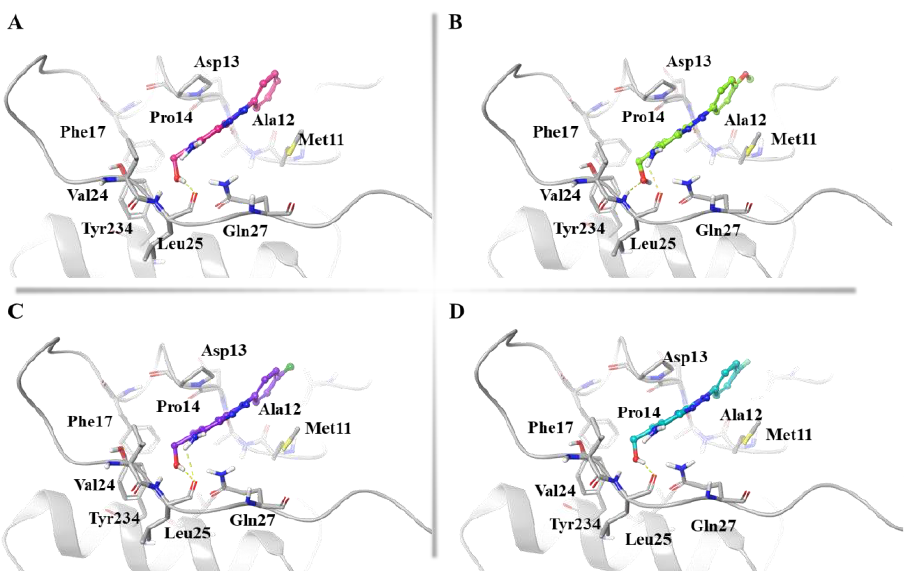
Figure 6. 3D representation of ( A ) 14 , ( B ) 16 , ( C ) 83 , and ( D ) 85 in complex to the most populated cluster of gD-Pocket 1. gD-Pocket 1 is illustrated in gray, with the residues involved in pivotal contacts shown as carbon sticks. 14 , 16 , 83 , and 85 are depicted as pink, green, violet, and cyan carbon sticks, and H-bonds are indicated as yellow dashed lines.